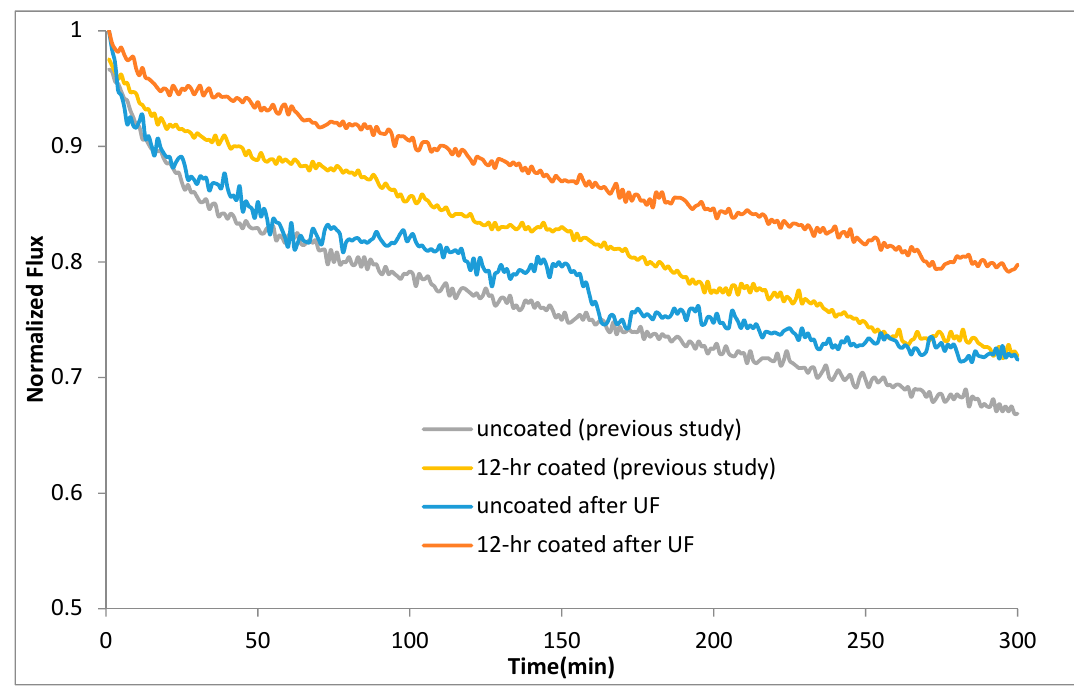
Figure 11. The effect of UF on the fouling behavior of the uncoated and the coated FO membranes. Figure 11. The e ff ect of UF on the fouling behavior of the uncoated and the coated FO